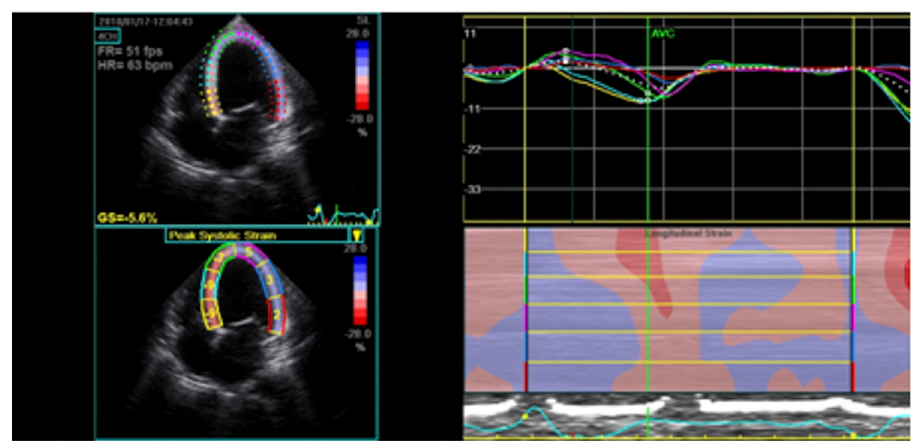
Fig 1. Peak systolic longitudinal strain of the left ventricle obtained at apical 4-chamber view. Parametric (color- coded) display of end-systolic strain (left upper panel); segmental peak systolic strain values are indicated (left lower panel); strain-time curves: colored curves displaying segmental strain (right upper panel); M-mode representation of peak systolic strain (right lower panel).